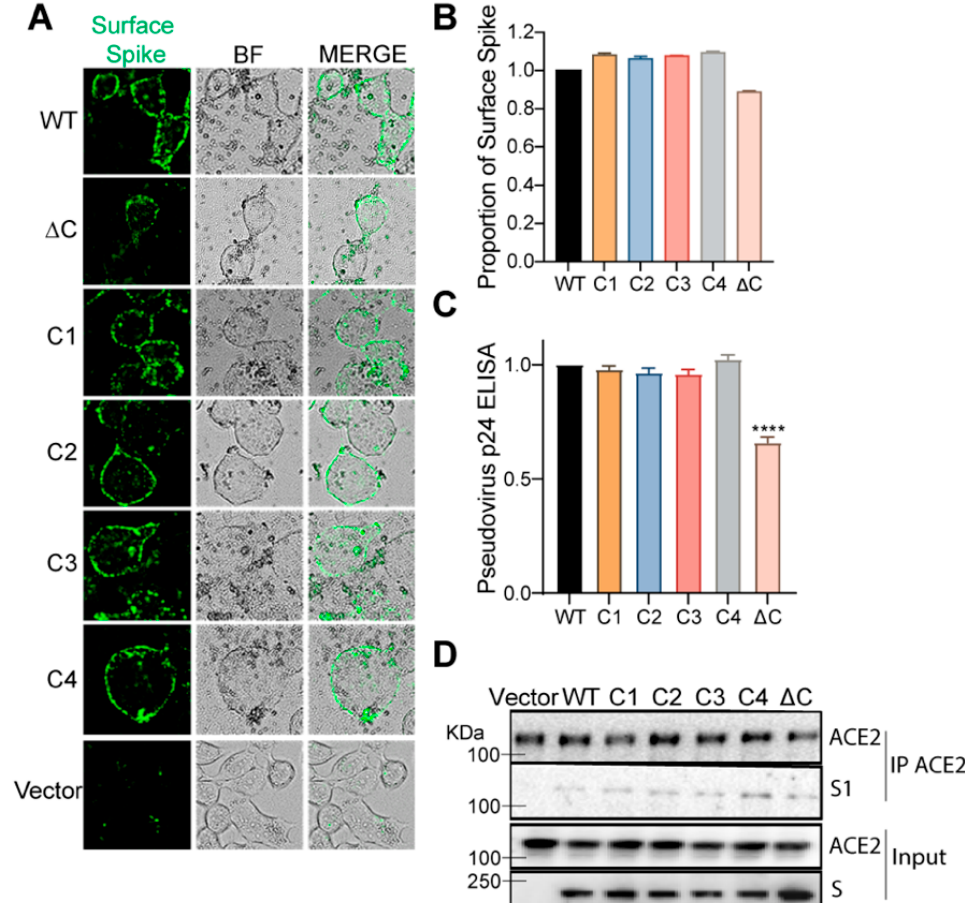
Figure 2. Effect of cysteine cluster mutations of SARS-CoV-2 S protein on its plasma membrane localization, egress and ACE2 binding. ( A ) Surface immunofluorescence assay for the S protein was performed by using anti-S protein antibodies on unpermeabilized HEK293T cells 48 h after transfection with WT or cysteine cluster mutant S proteins. BF indicates bright field. ( B ) FLOW cytometry assay measuring the ratio of surface expressed S protein vs. total intracellular S protein expressed. ( C ) HEK293T cells were transfected with plasmids for SARS-CoV-2 S protein pseudotyped lentivirus and 48 h later, supernatants containing pseudotyped lentivirus particles (WT and cysteine mutants) were assayed for pseudovirus egress by ELISA against the lentivirus (HIV) p24 protein. ( D ) Co-immunoprecipitation assay. Plasmids expressing WT or different cysteine cluster mutant S proteins were transfected into HEK293T-ACE2 cells. ACE2 was immunoprecipitated 48 h after transfection, and the presence of S protein was assayed by immunoblot using antibody specific to the S1 subunit. ACE2 immunoprecipitation was also confirmed. Inputs were quantitated by immunoblot (bottom panels). Data shown are averages of the results of at least three independent experiments ± SD. (**** p < 0.0001 ( t